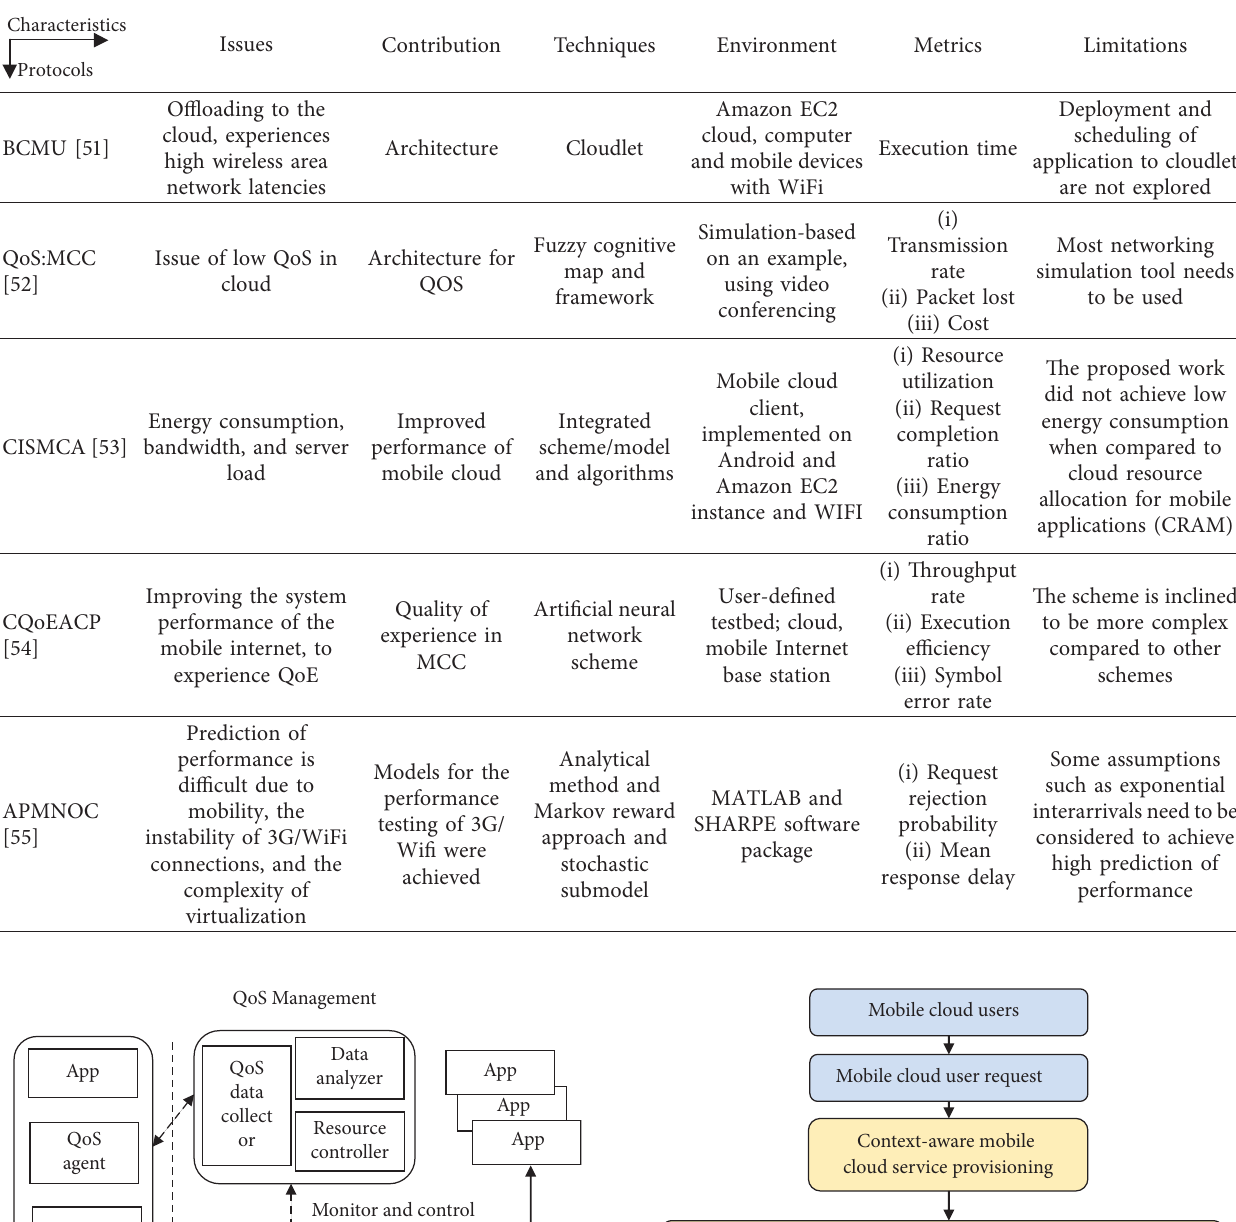
Table 5: Summary of Quality of Service-aware development in MCC.